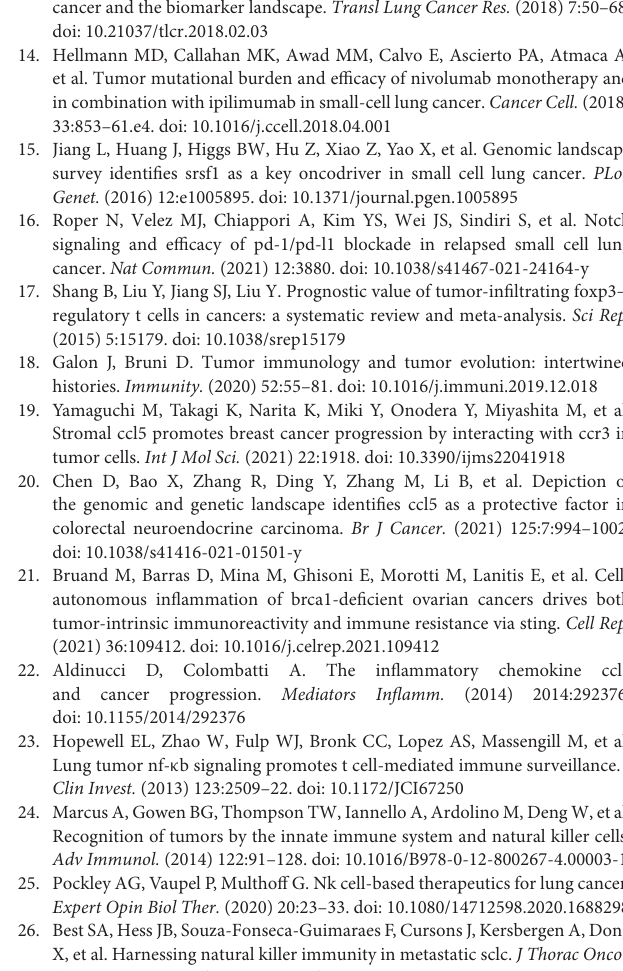
Supplementary Figure 1 | (A) The optimal cutoff point for the expression of CCL5 in the Jiang study. (B) The optimal cutoff point for the expression of CCL5 in the George study. (C) The optimal cutoff point for the expression of CCL5 in the Roper cohort. Supplementary Table 1 | The co-expression genes of